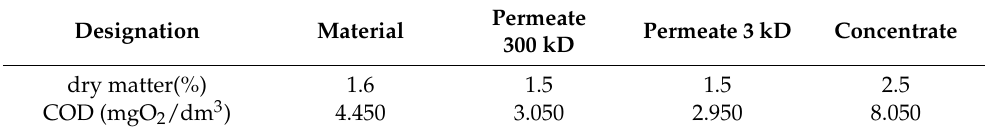
Table 8. The parameters of sewage